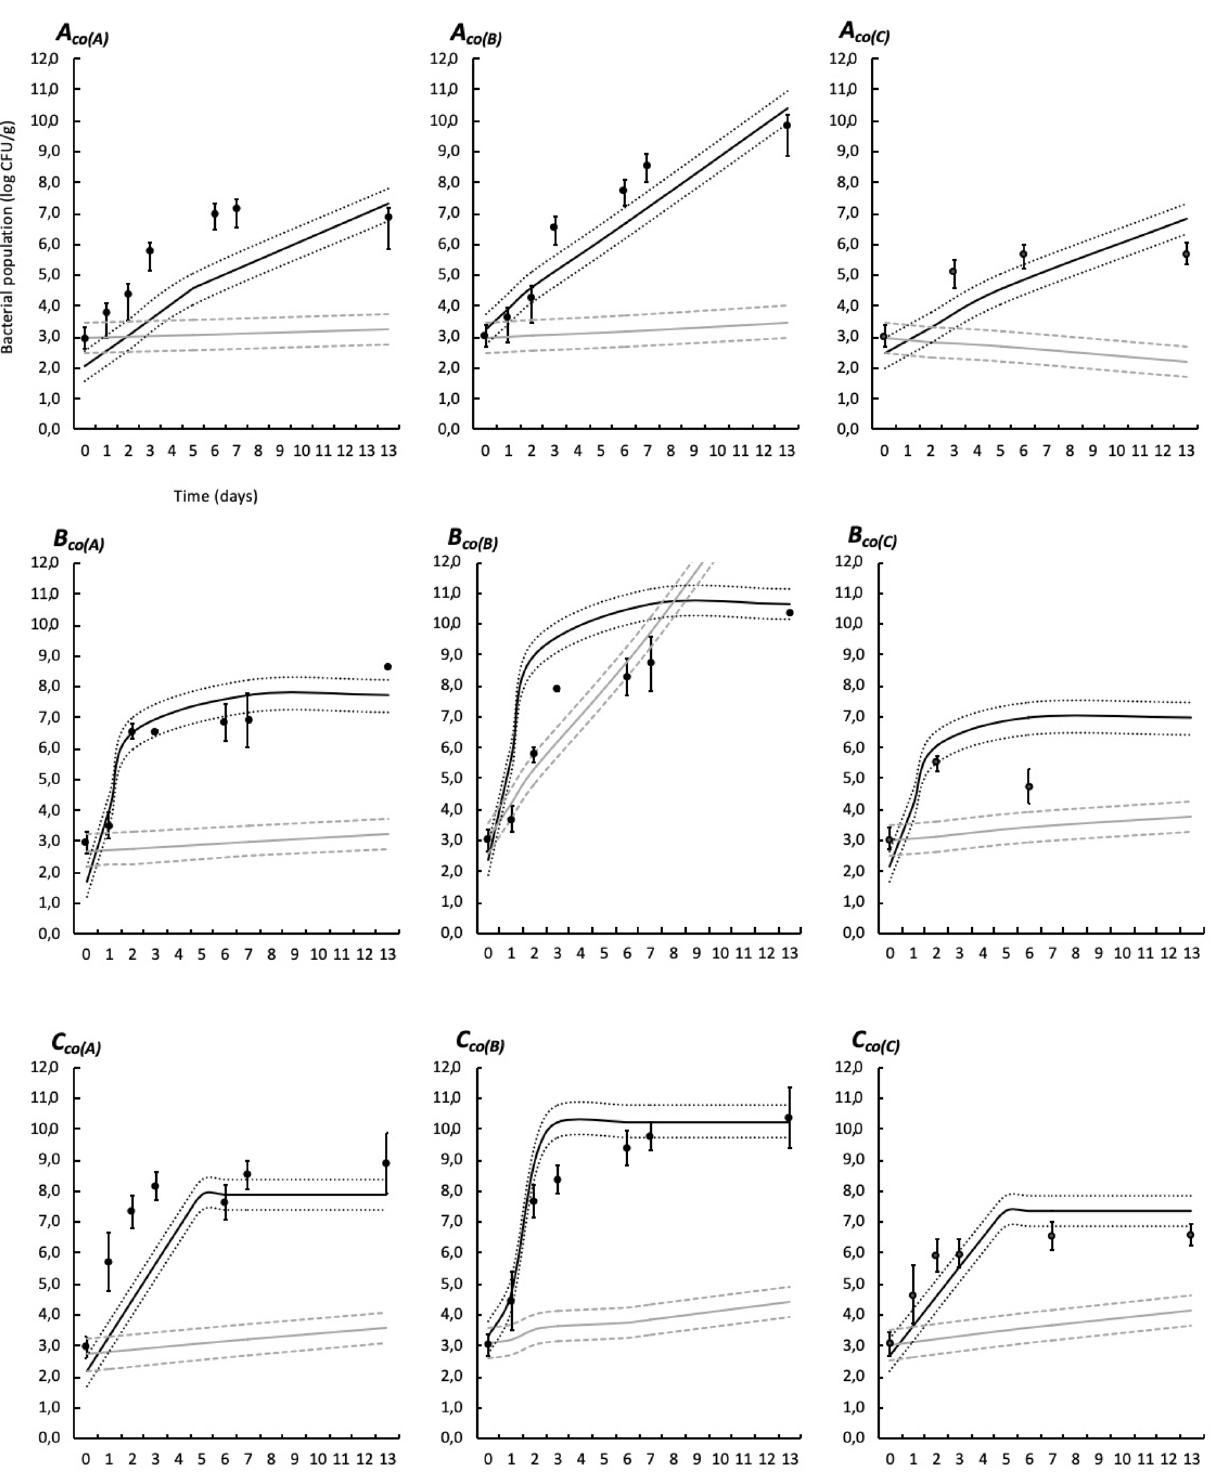
Frontiers in Microbiology |